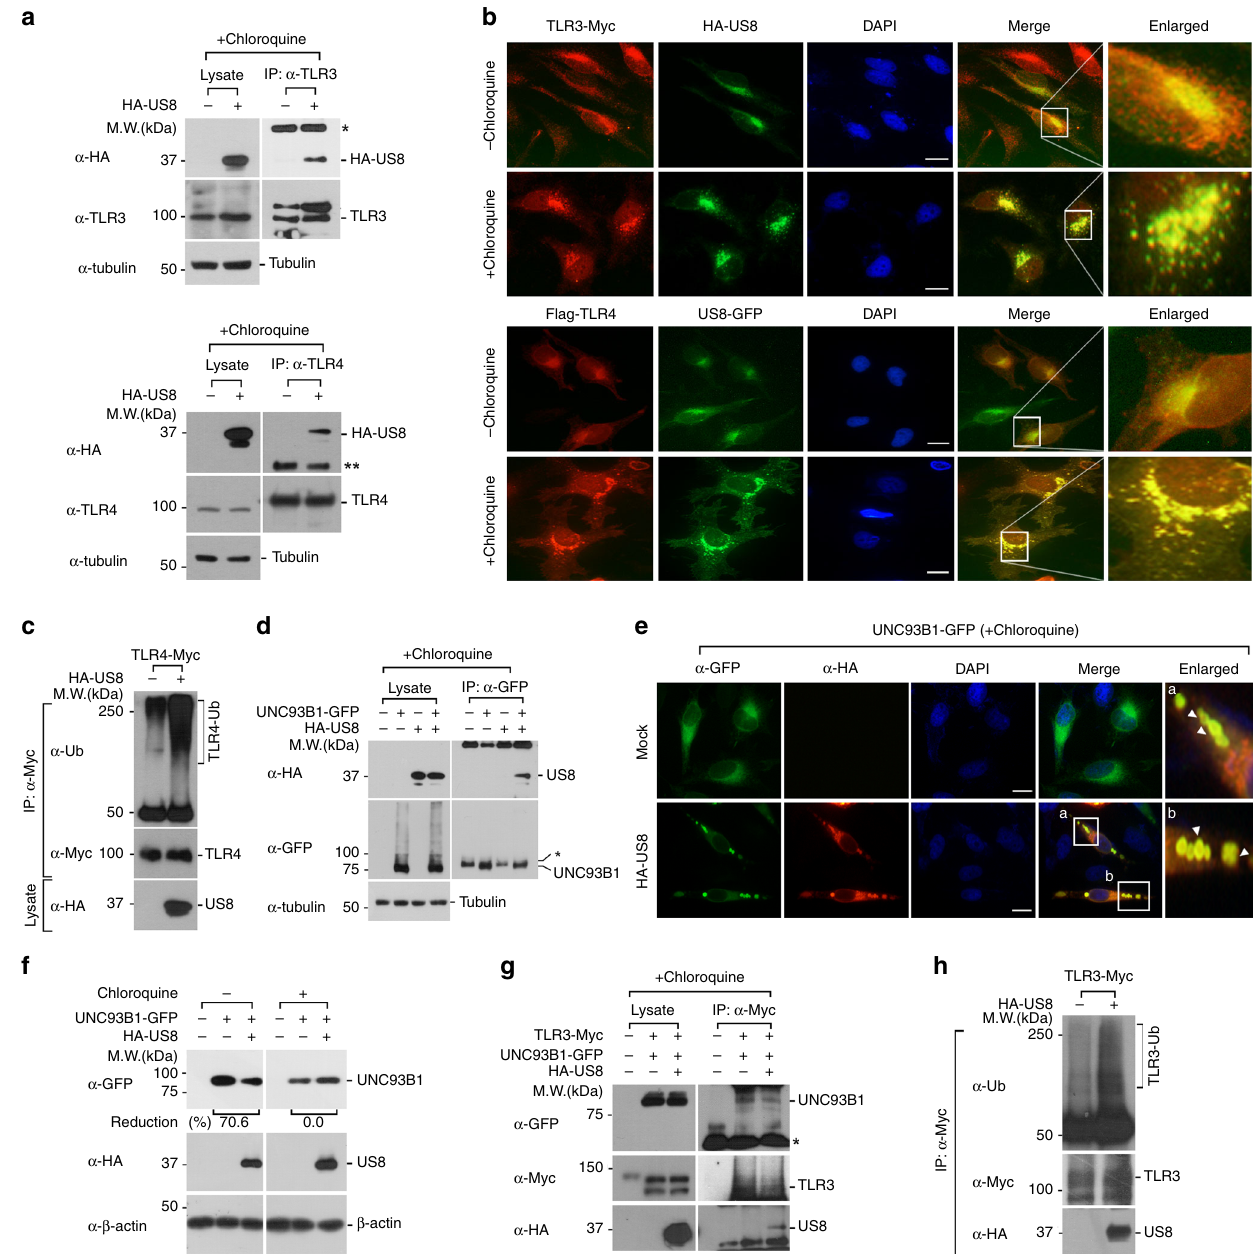
Fig. 4 US8 promotes TLR3 and TLR4 destabilization by disrupting TLR3-UNC93B1 interaction and targeting TLR4 to lysosomes. a US8 interacts with TLR3 and TLR4. HeLa cells were transfected with empty vector or HA-US8 and then treated with 100 μ M chloroquine for 4 h. Lysates were immunoprecipitated with anti-TLR3 or anti-TLR4 antibody and immunoblotted with anti-TLR3, anti-TLR4, anti-HA, or anti-Tubulin antibody. *, Ig heavy chains; **, Ig light chains. b US8 co-localizes with TLR3 or TLR4. HeLa cells expressing TLR3-Myc or Flag-TLR4/MD-2-Myc were transfected with empty vector, HA-US8 or US8- GFP treated with or without chloroquine, and then stained with anti-Myc, anti-Flag or anti-HA antibody. DAPI was used as a nuclear counterstain. Scale bars, 10 μ m. c US8 promotes TLR4 ubiquitination. Cells expressing TLR4-Myc with or without HA-US8 were treated with 20 μ M MG132 for 4 h and lysed. Cell extracts were immunoprecipitated with anti-Myc antibodies and then analyzed by immunoblotting with indicated antibodies. d , e US8 associates with UNC93B1. HeLa cells expressing UNC93B1-GFP were transfected with empty vector or HA-US8 and immunoblotted d or stained e with indicated antibodies. Scale bars, 10 μ m. *, non-speci fi c bands. f US8 reduces UNC93B1 stability in a lysosome-dependent manner. HeLa cells expressing UNC93B1- GFP were transfected with empty vector or HA-US8 and treated with 100 μ M chloroquine for 4 h. Lysates were immunoblotted with the indicated antibodies. g US8 disrupts the TLR3-UNC93B1 interaction. TLR3-Myc-expressing HeLa cells were transfected with UNC93B1-GFP and empty vector or HA- US8 and then treated with 100 μ M chloroquine. Lysates were immunoprecipitated with anti-Myc and immunoblotted with anti-GFP and anti-Myc or anti- HA antibody. *, Ig heavy chains. h US8 promotes TLR3 ubiquitination. Cells expressing TLR3-Myc with or without HA-US8 were treated with 20 μ M MG132 for 4 h and lysed. Cell extracts were immunoprecipitated with anti-Myc antibodies and then analyzed by immunoblotting with indicated antibodies. Data are representative of at least three independent experiments. Source data are provided as a Source Data fi